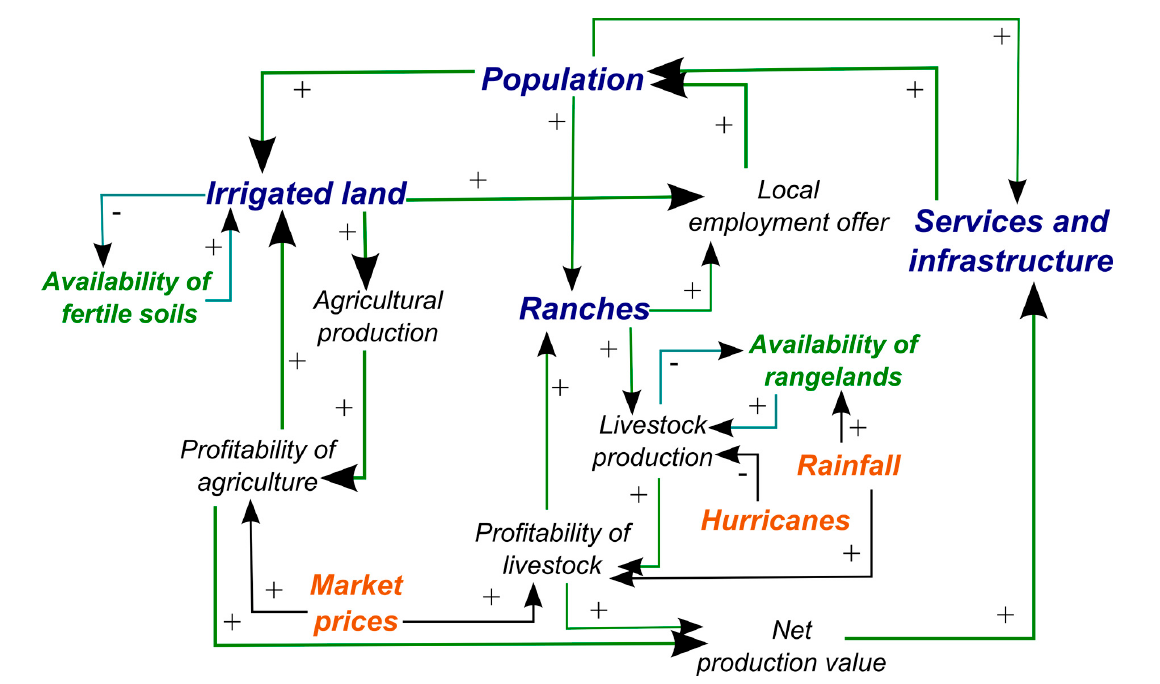
Fig. 6 . The causal diagram of the underlying system structure. The diagram and the feedback loops are explained in the text. The main variables of the system are marked in blue with larger letters. Environmental limits are depicted in green. The external conditions or forcing functions are marked in orange. Blue arrows are negative feedback loops. Green arrows are positive feedback loops (virtuous cycles). The feedback loops associated with agriculture are larger because they have a heavier relative